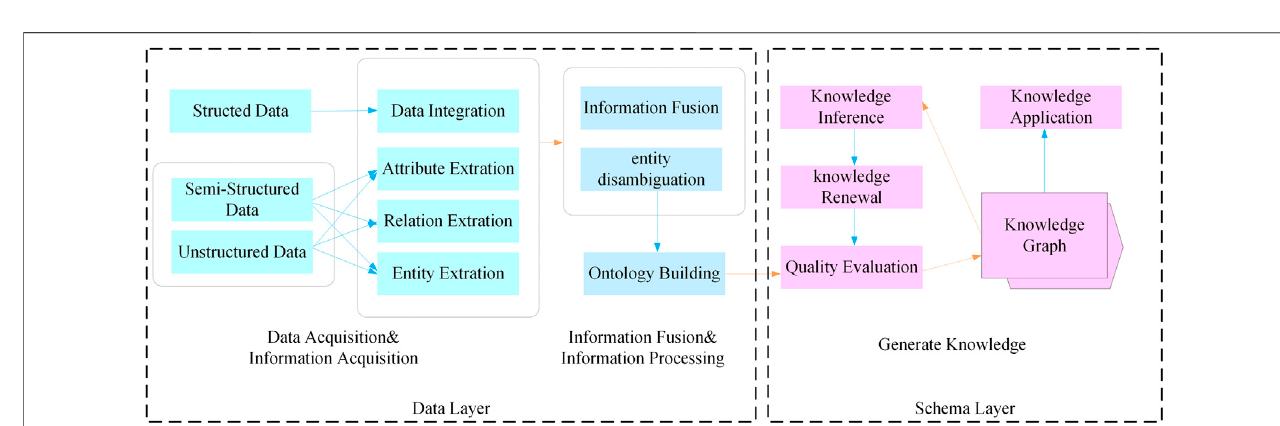
FIGURE 1 | The architecture of the knowledge